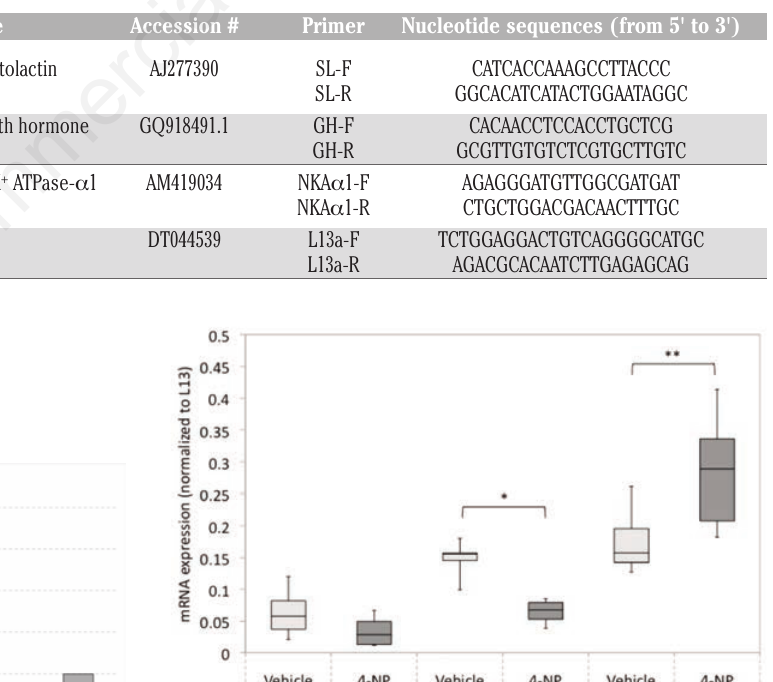
Table 1. Primer sequences used in this study.